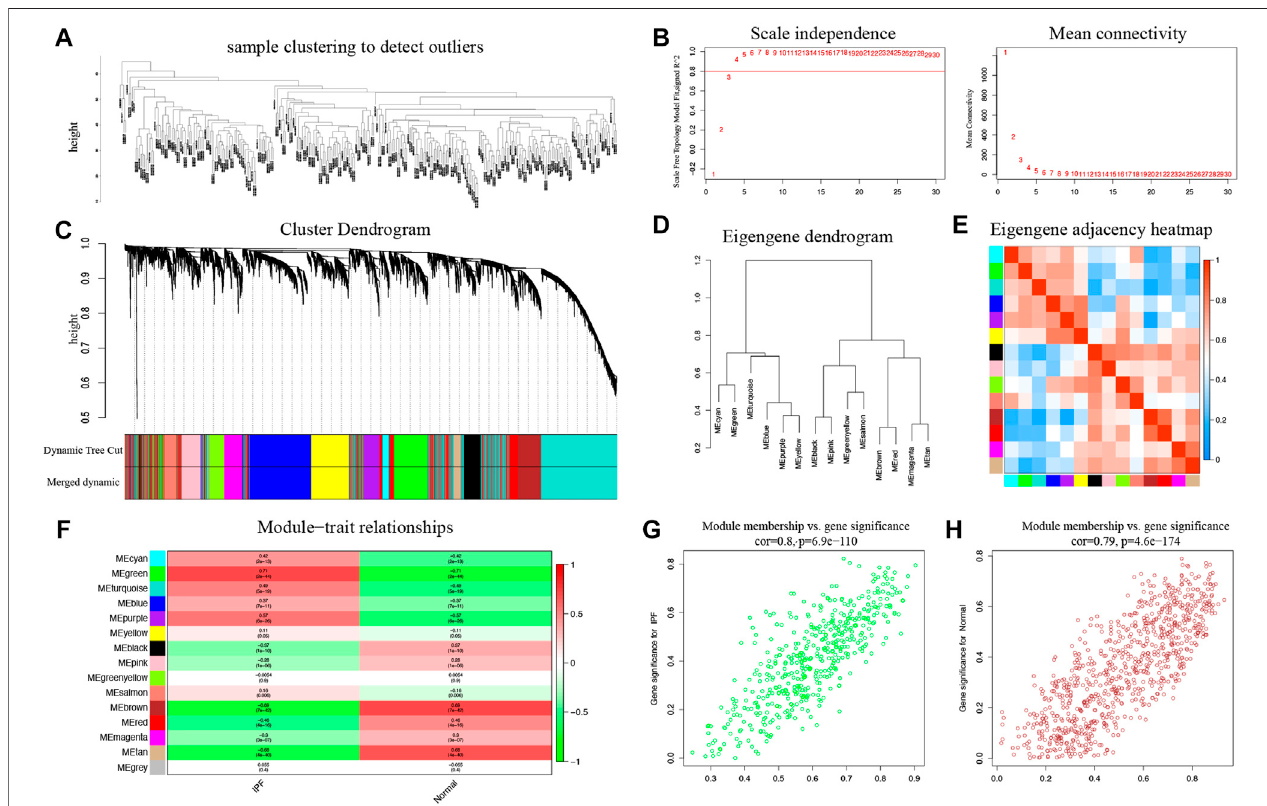
FIGURE2| Key modules identi fi ed by WGCNA in the training group. (A) Sample clustering to detect outliers. (B) Determination of soft-thresholding power. (C) Clusteringdendrogram.Bothoftheoriginalandthemergedmoduleswerepresented. (D) DendrogramofconsensusmoduleeigengenesobtainedfromWGCNAon the consensus correlation. (E) Dendrogram of merged module eigengenes obtained from WGCNA. (F) The module-trait relationships were evaluated by correlating module eigengenes with clinical traits. (G) Scatter plots of module eigengenes in the green modules. (H) Scatter plots of module eigengenes in the brown